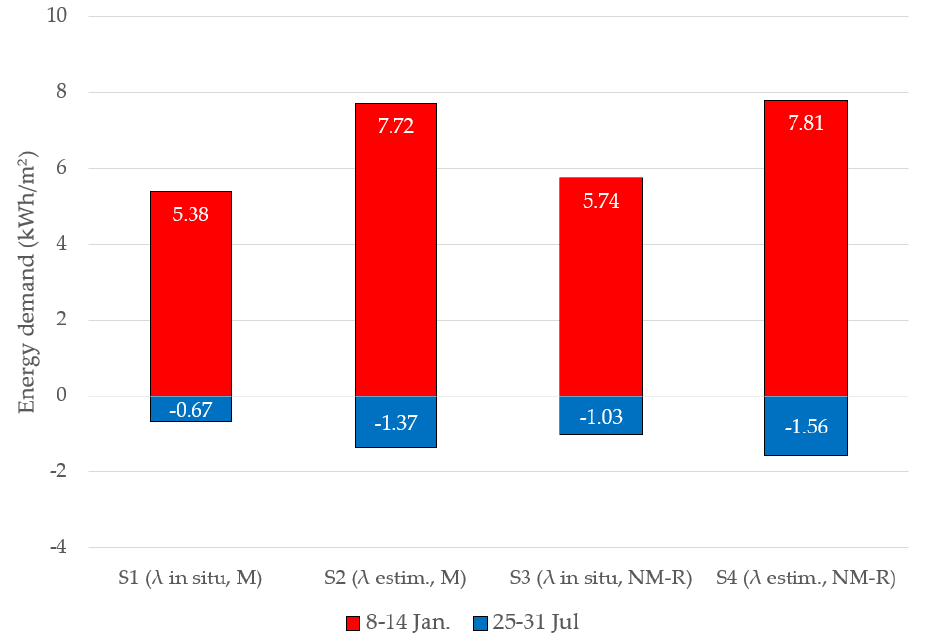
Figure 9. Energy demand of the room due to heating and cooling. S1 to S4 during the selected weeks.